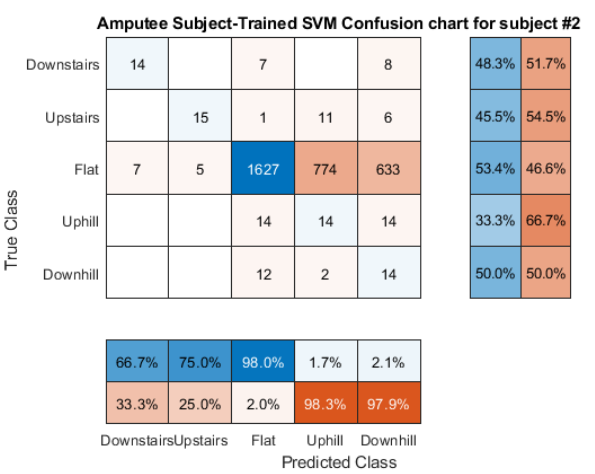
Figure A11. Support Vector Machine Confusion Chart for ILLA participant A1 as trained by all other ILLA participants.